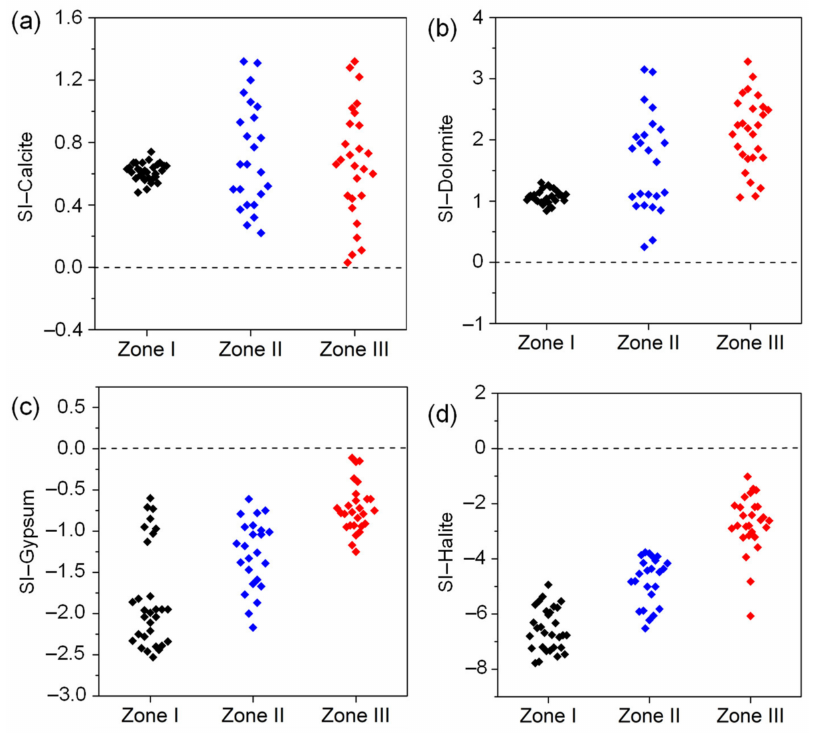
Figure 10. SI values of calcite ( a ); dolomite ( b ); gypsum ( c ); and halite in different hydrogeochemical zones ( d